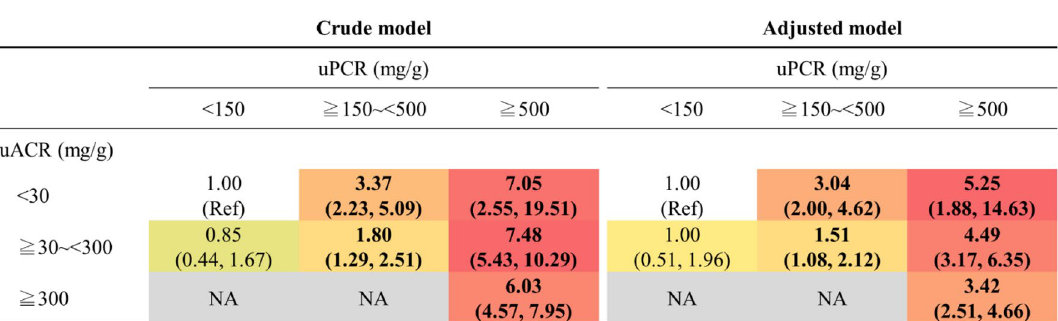
Figure 3. Risk matrices demonstrating aHRs for all-cause mortality according to the concordant pattern among categories of uPCR (< 150, ≥ 150 to < 500, and ≥ 500 mg/g creatinine) and uACR (< 30, ≥ 30 to < 300, and ≥ 300 mg/g creatinine). The color of the reference cells and cells with a risk estimate equal to 1.0 is white, which stands for the group with uPCR < 150 mg/g creatinine and uACR < 30 mg/g creatinine. For a hazard ratio below 1.0, we used green color, whereas for a hazard ratio above 1.0, we used red. We colored the cells from light (close to 1.0) to dark (toward risk or protective) based on the range of the risk estimates of each 3 × 3 table. Cells without risk estimates (NA) are colored gray. The numbers in bold indicate that they are significant ( P <